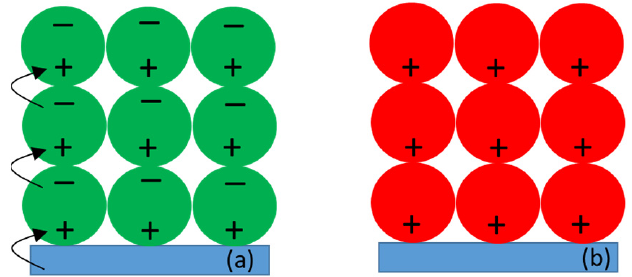
Figure 8. Extreme theoretical voltage effects on the photoactivity of PSI particles in the absence of the redox compounds. ( a ) Low voltage (all PSI complexes contain charge-separated states due to saturating excitation, followed by ET between proteins); ( b ) high voltage (all PSI complexes contain oxidized P). Green circle—photoactive PSI, red circle—inactive PSI, blue rectangle—FTO glass slide. Note that, for simplicity, only homogeneous orientation of the PSI particles is depicted. Figure 7 shows that the initial P + photobleaching signal ( − ∆ A 0 ) depended not only on the value of the applied potential, but also on the sequence of applied potentials. Points